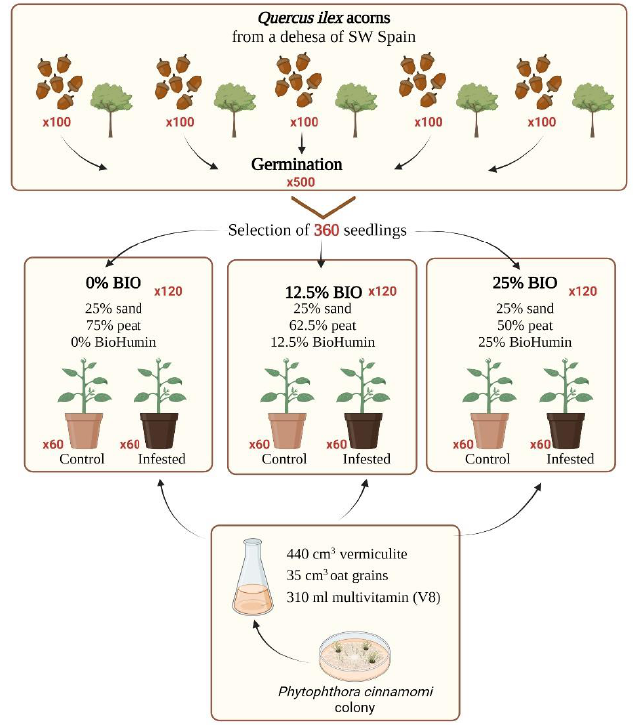
Figure 1. Experimental design including details of acorn sampling, soil fertilisation, acorn germina- tion, plant growth, and P. cinnamomi soil infestation. Red numbers refer to the sample size at each step.